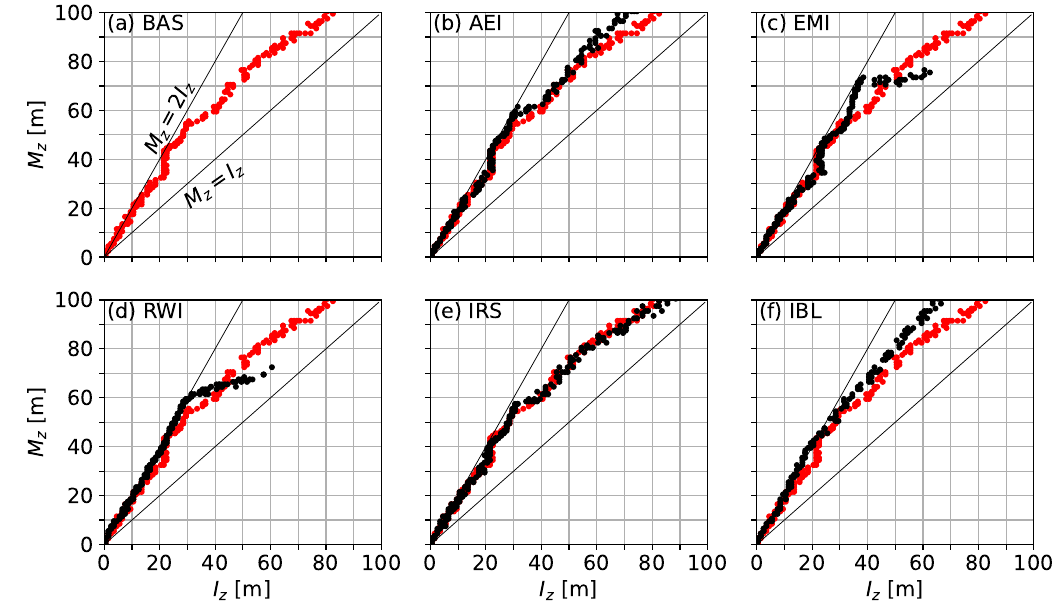
Figure 8. M z vs. I z for the simulations, with M z = 2 I z and M z = 2 I z for comparison. ( a ) BAS simulation. ( b – f ) Labelled simulation (black) on top of BAS simulation